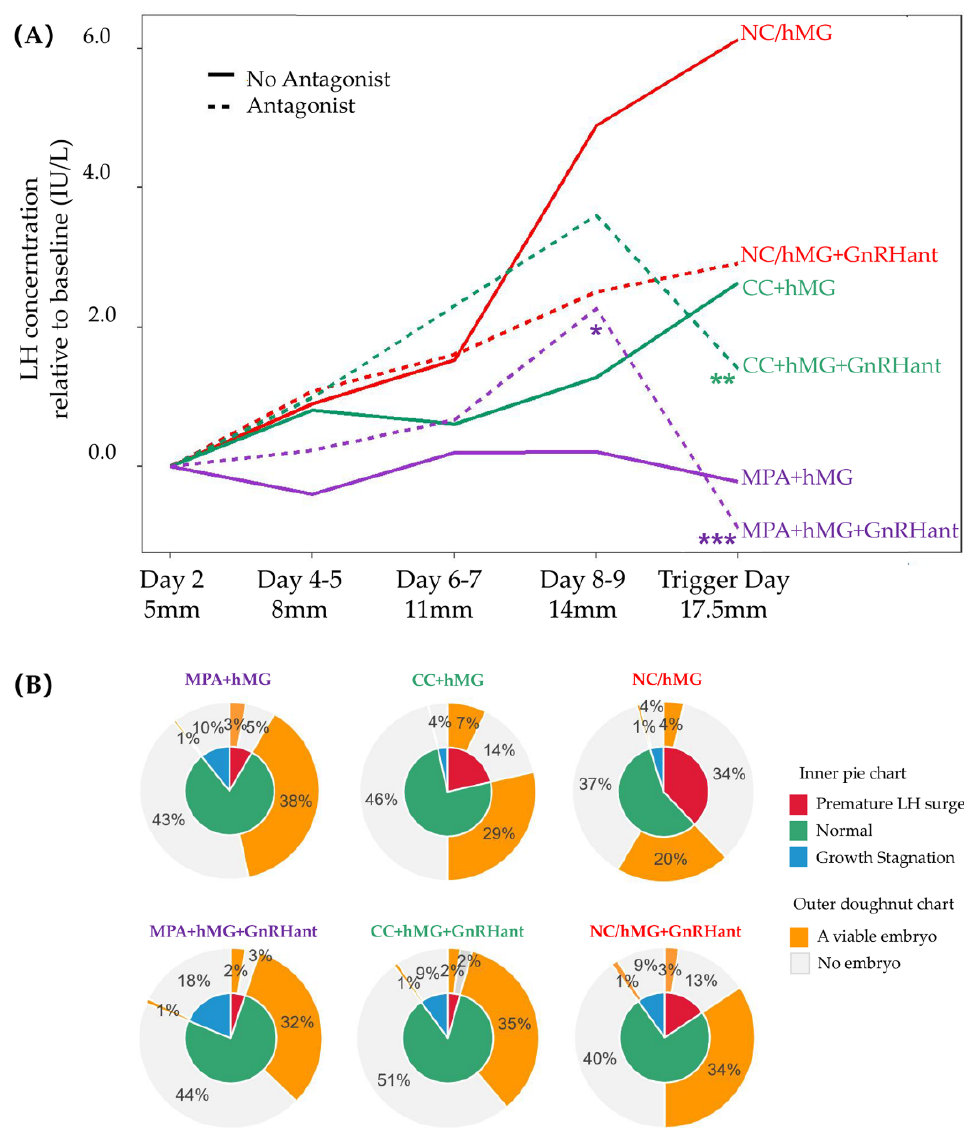
Figure 1. LH profile in monofollicular IVF cycles using various stimulation protocols. ( A ) LH levels were shown as the difference relative to baseline. * denoted that LH levels at this time point were significantly different from the previous measurement, *: p < 0.05, **: p < 0.01, ***: p < 0.001. The means, standard deviations and p values of pairwise comparisons are listed in Supplementary Table S2 out of aesthetic considerations. ( B ) The inner pie chart denotes the proportions of growth stagnation (blue), premature LH surge (red) and normal growth (green) in monofollicular IVF cycles. The outer doughnut chart showed the chances of obtaining a viable embryo (golden) or not (grey) on the conditions of growth stagnation, LH surge and normal growth, respectively.